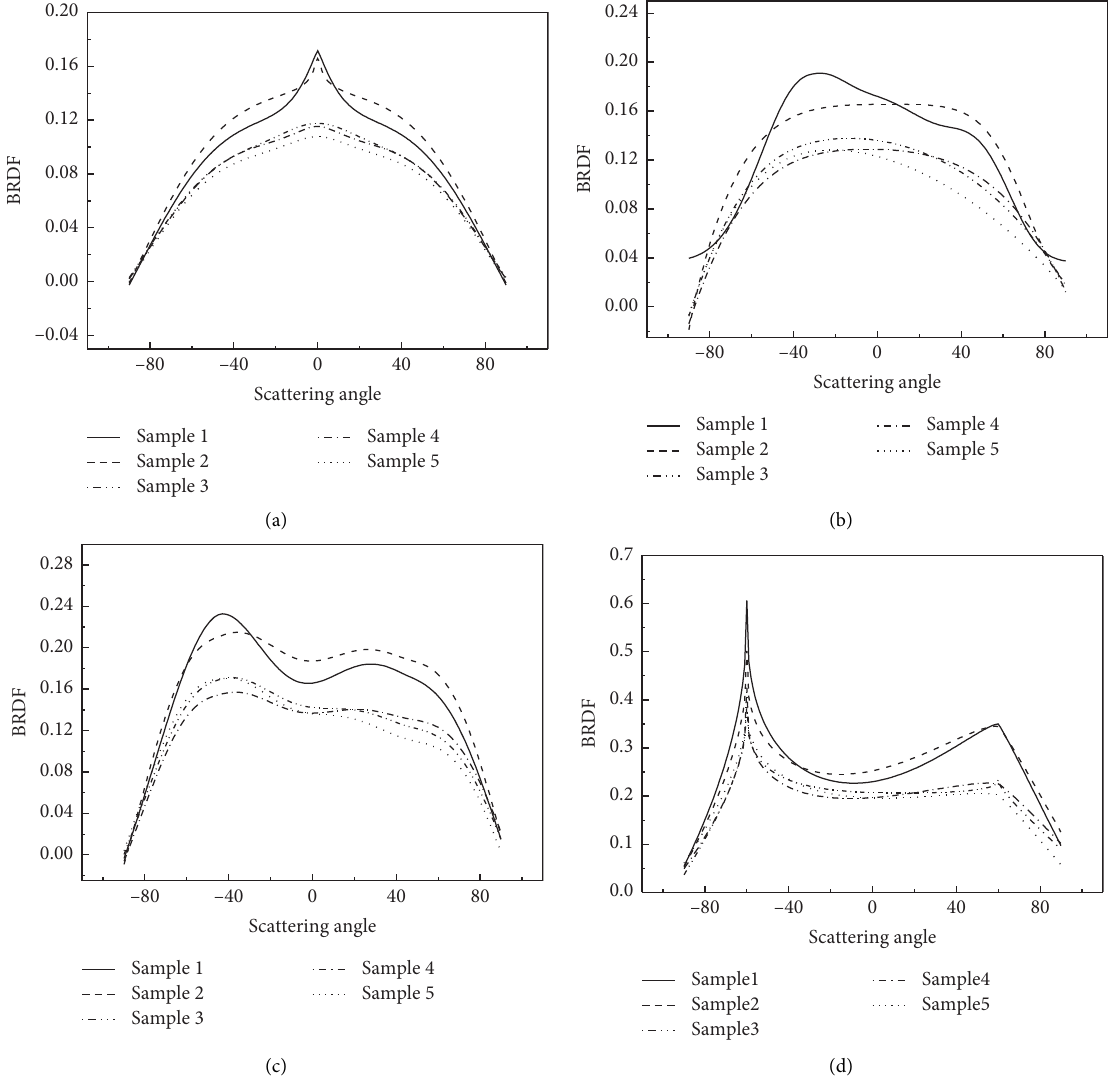
Figure 9: Fitted curves of Mars soil BRDF and Earth sand BRDF. (a) Fitted curve of 0 ° incident angle; (b) fitted curve of 30 ° incident angle; (c) fitted curve of 45 ° incident angle; (d) fitted curve of 60 ° incident angle.